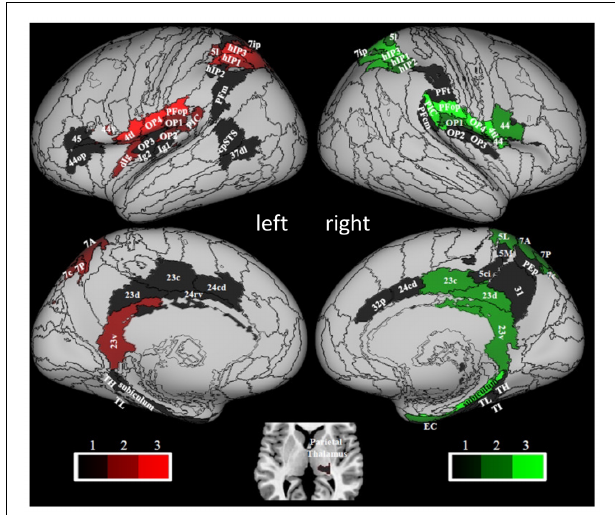
FIGURE 3 | Hubness within the vestibular network computed by using data of 794 right-handed individuals drawn from the Human Connectome Project repository. PIC and OP2 are among the vestibular areas with the strongest hubness index. Red and green colors relate to regions in the left and right hemispheres, respectively. Brain regions are mapped onto the Conte69 inflated brain. Labels correspond to: parietal opercula 1, 2, 3, 4 (OP1, 2, 3, 4), caudal posterior superior temporal sulcus (cpSTS), area 4 tongue and larynx region (4 tl), granular insula 2 (Ig2), granular insular 1 (Ig1), Area supramarginalis opercularis (PFop), rostroventral area 40 (PIC), area supramarginalis columnata magnocellularis (posterior; PFcm), area supramarginalis tenuicorticalis (PFt), area supramarginalis magnocellularis (PFm), caudal posterior superior temporal sulcus (cpSTS), dorsolateral area 37 (37 dl), human intraparietal 1, 2, 3 (hIP1, 2, 3), lateral area 5 (5I), intraparietal area 7 (7ip), superior parietal lobe (5 ci), area 31 (31), dorsal area 23 (23 d), caudal area 23 (23 c), ventral area 23 (23v), caudodorsal 24 (24 cd), pregenual area 32 (32p), ventral area 44 (44v), rostral area 45 (45), opercular area (44op), dorsal granular insula (dIg), granular insula 2 (Ig2), hippocampotemporalis (TH), subiculum, latero posterior parahippocampal gyrus (TL), temporal agranular insular cortex (TI), entorhinal cortex (EC). Figure drawn from Indovina et al.